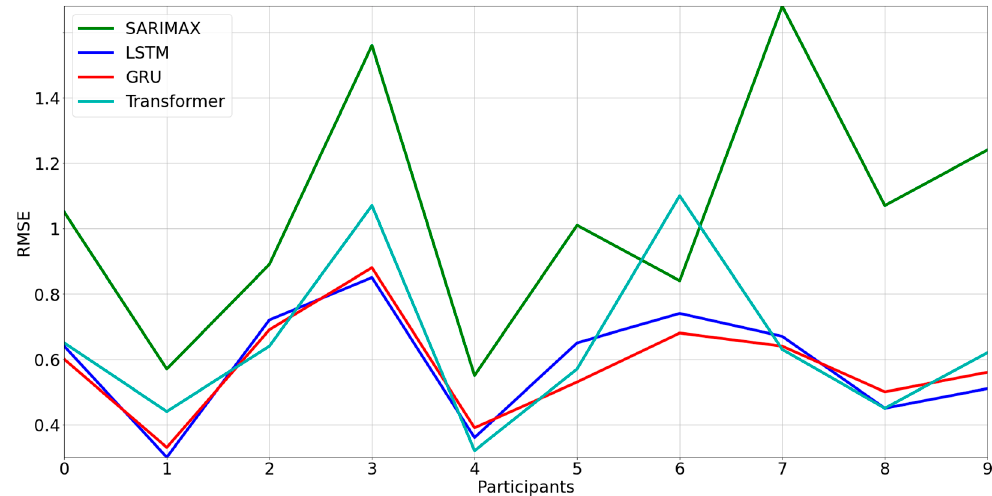
Figure 6. RMSEs for each model versus users.